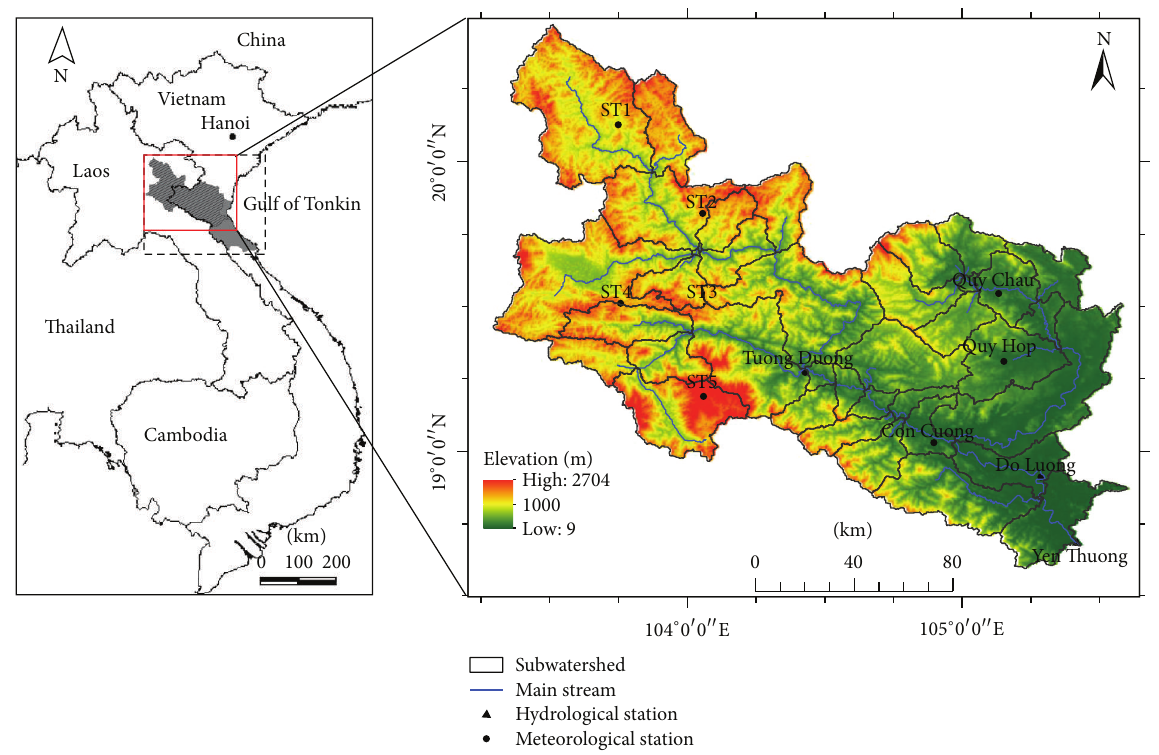
Figure 1: Geographic location of the entire Ca River Watershed (left) and the UCRW (right).